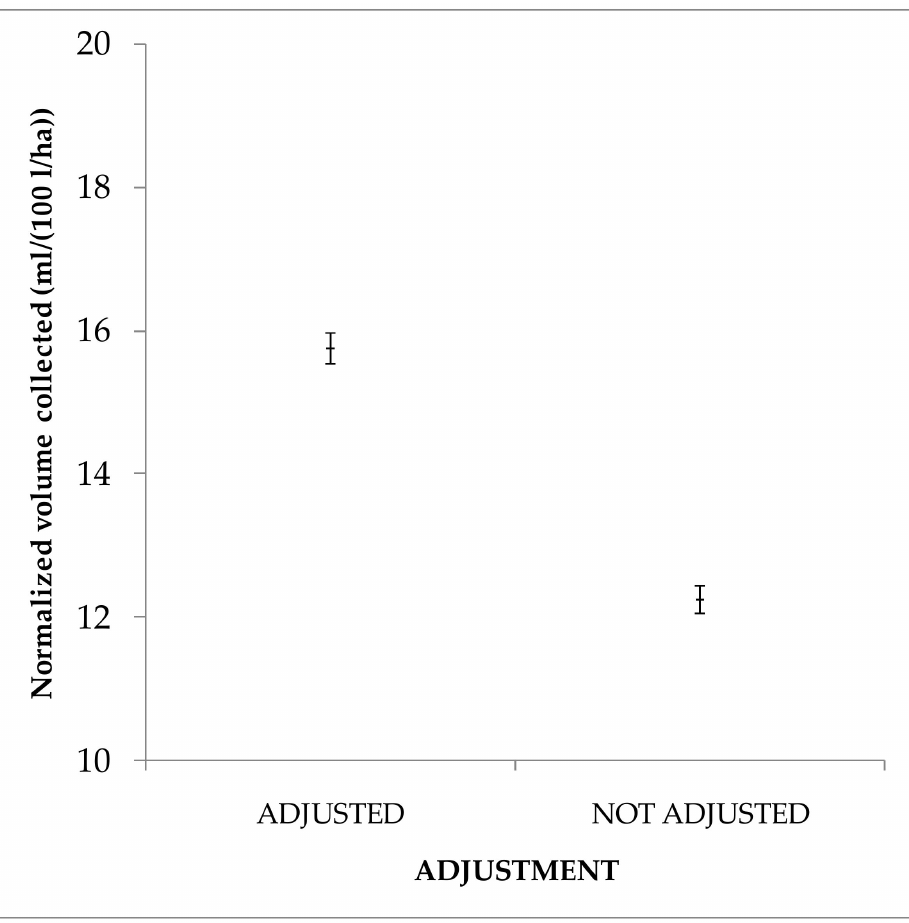
Figure 21. Adjustment effect on the normalized volume collected in the canopy zone (mean ± SE) with the C2